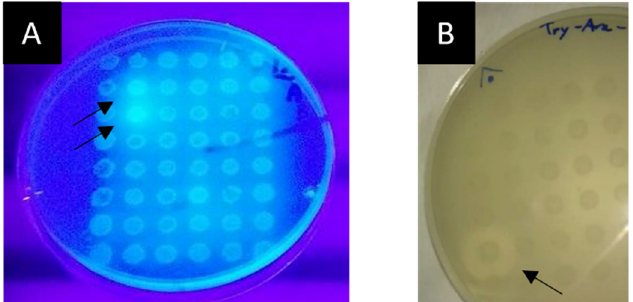
Figure 1. Activity screening results. ( A ) β -Xylosidase activity screening with two positive hits from the As Burgas Metagenomic library using MUX as the substrate. Observation under UV light for fluorescence around the colonies is required to identify positive hits. The black arrows indicate the location of two positive hits. ( B ) Lipolytic activity screening with a positive hit from the As Burgas metagenomic library using glyceryl tributyrate as the substrate. Direct observation of halos surrounding the colonies possessing the activity allows to identify positive hits. The black arrow points towards the positive hit.